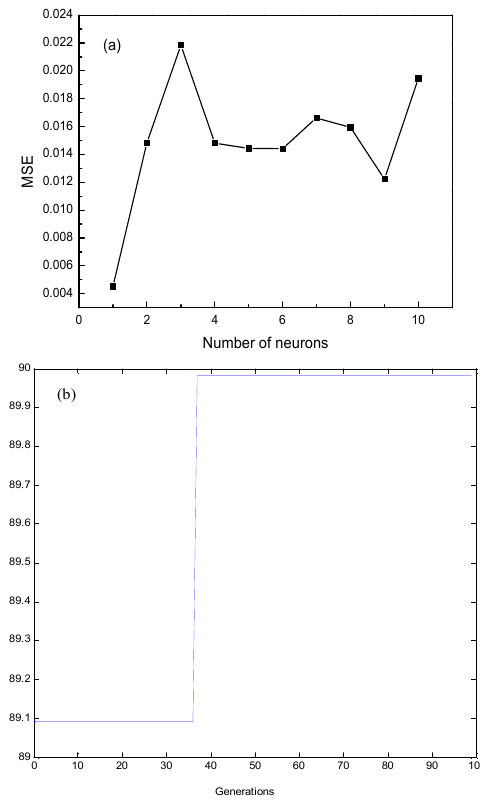
Figure 12. Relationship between the number of neurons and mean square error (MSE) ( a ); Evolvement of fitness with 100 generations ( b ).